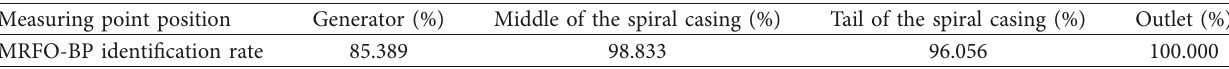
Table 3: Identification rates of three units based on MRFO-BP neural network. Measuring point position